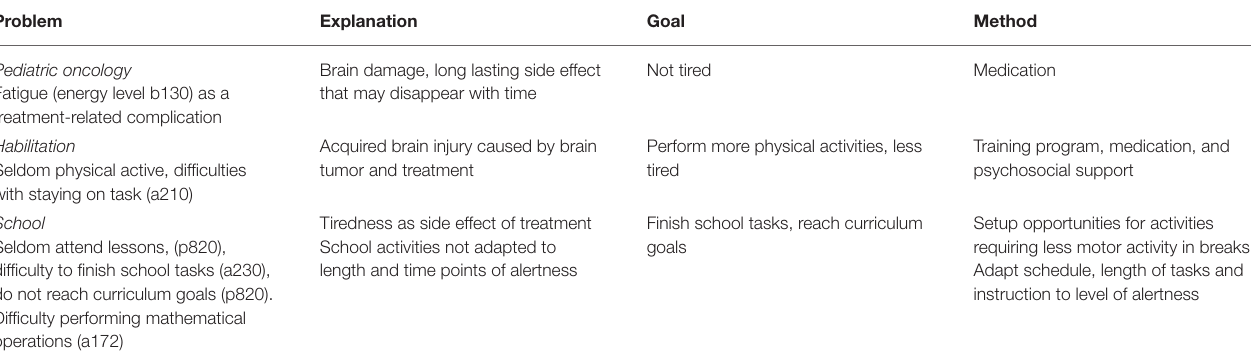
TABLE 4 | Problems identified as targets for intervention by organizations serving the